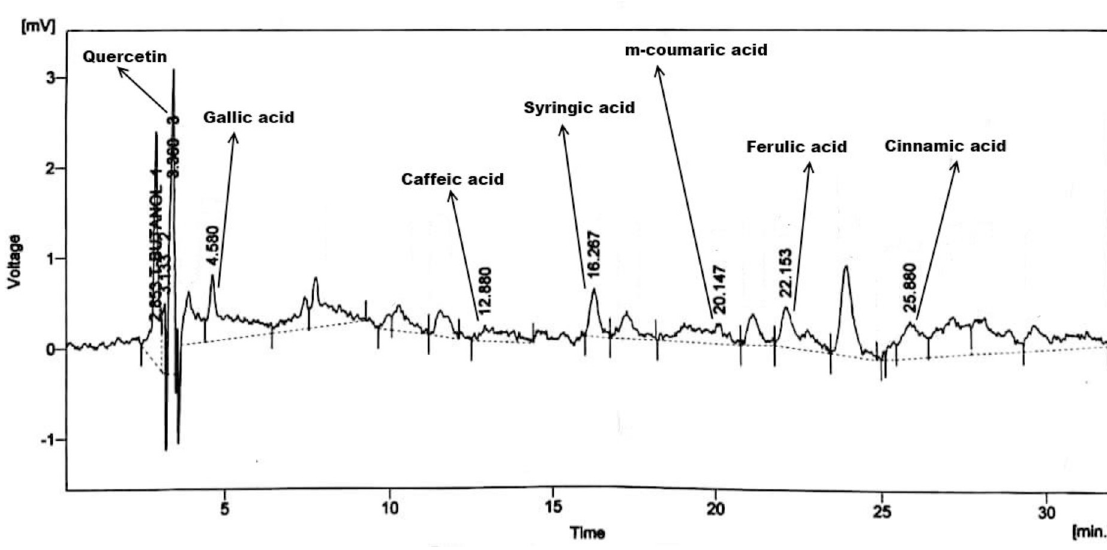
Fig 3. HPLC chromatogram of Euphorbia nivulia Buch.-Ham. crude extract.